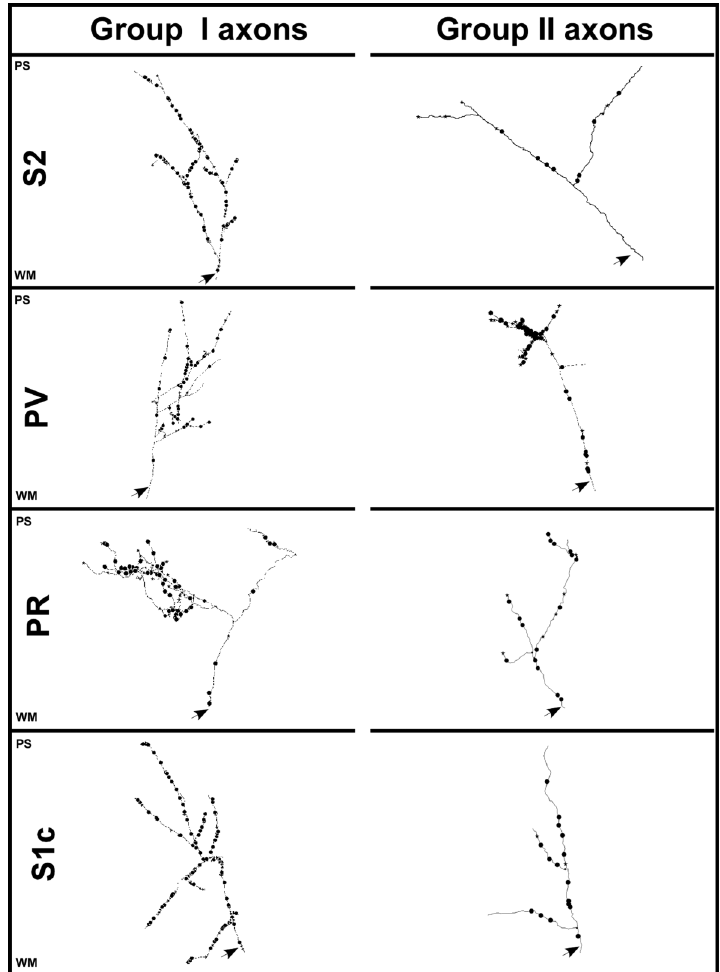
Figure 6 . Representative examples of digitally reconstructed axon terminals in secondary somatosensory area (S2), parietal rhinal area (PR), parietal ventral area (PV) and contralateral primary somatosensory area (S1c). Terminals are separated according to their pro fi le into groups I and II. The relative position of both the pia mater and white matter borders are depicted in the fi gure. Arrows indicate the parent axon branch. PS: pial surface; WM: white